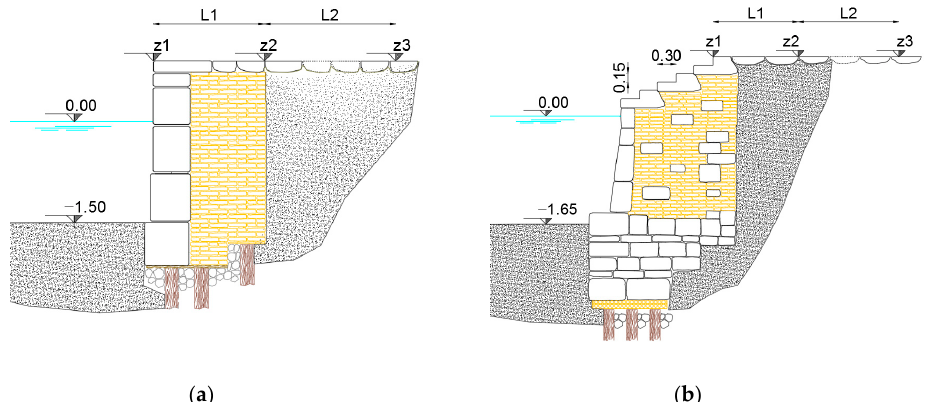
Figure 3. Cross-section of the quay at Riva S. Marco, in correspondence of the vertical wall ( a ) and of the descending steps ( b ). The water depths are referred to ZMPS.